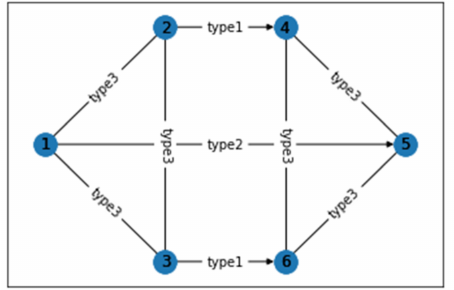
Figure 4. Assembly quality analysis network model.